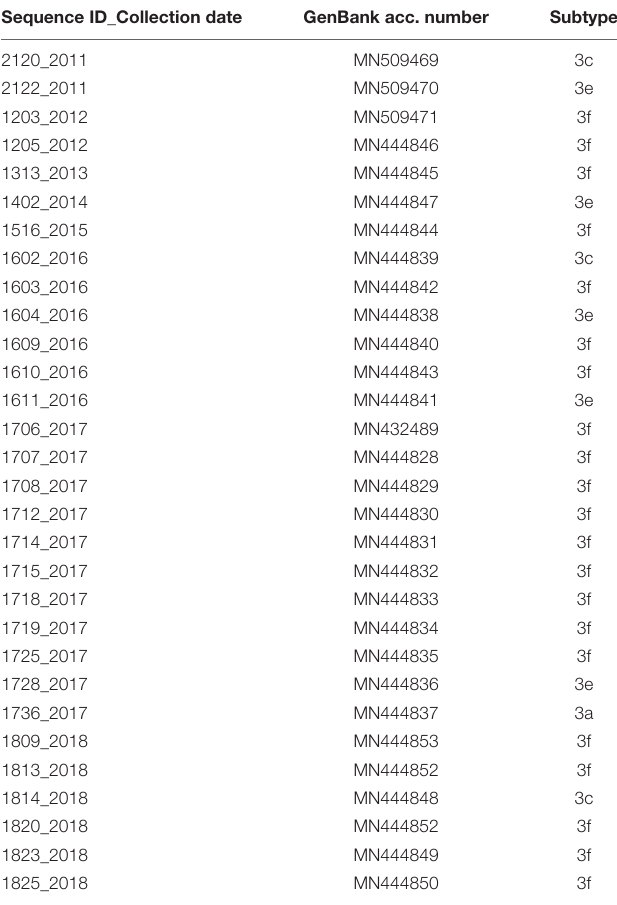
TABLE 2 | Sequence information of human HEV-3 sequences from Lazio region. TABLE 3 | Subtypes HEV-3 distribution of animal and human strains detected in